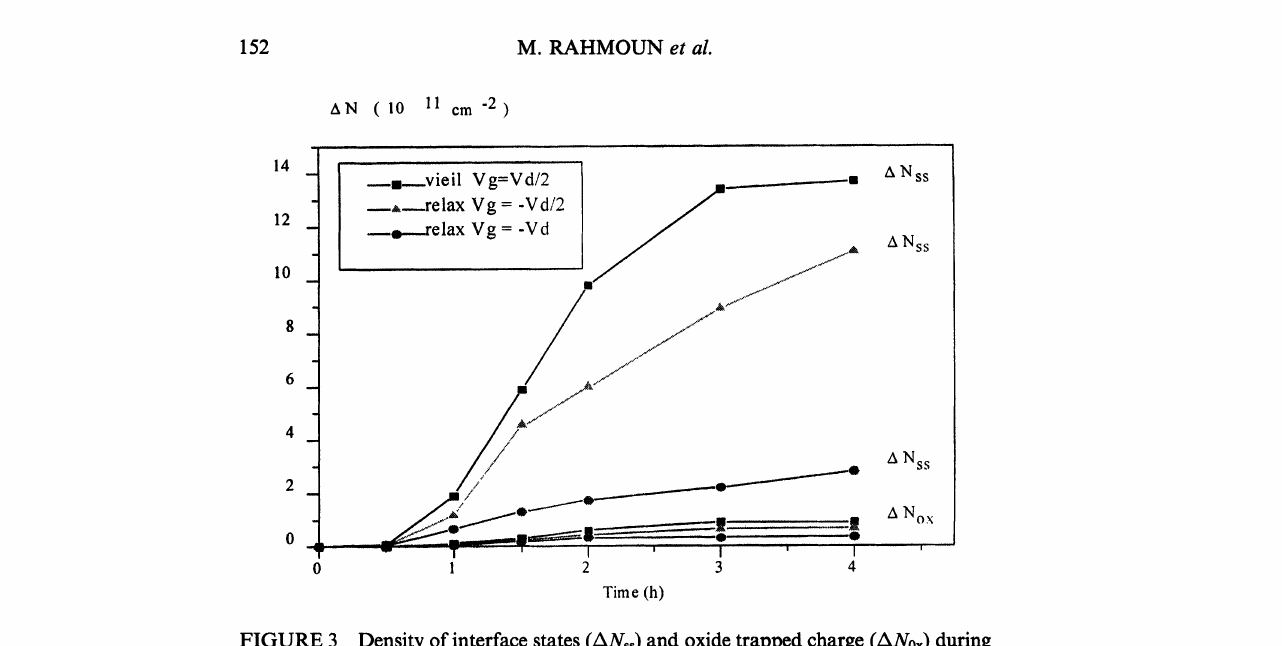
FIGURE 3 Density of interface states (ANss) and oxide trapped charge (AN0x) during stress at Vg Va/2, and during relaxation at Vg Va/2 and Vg